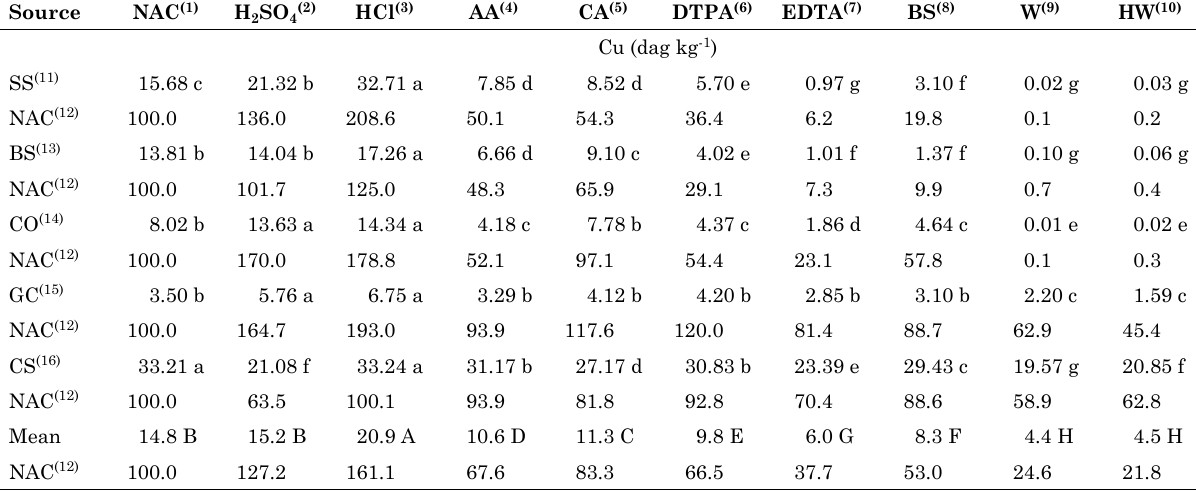
Table 5. Copper extracted by the extractants and percentage in relation to the extractant neutral ammonium citrate + water (1:1) (NAC) from industrial by-products and mineral